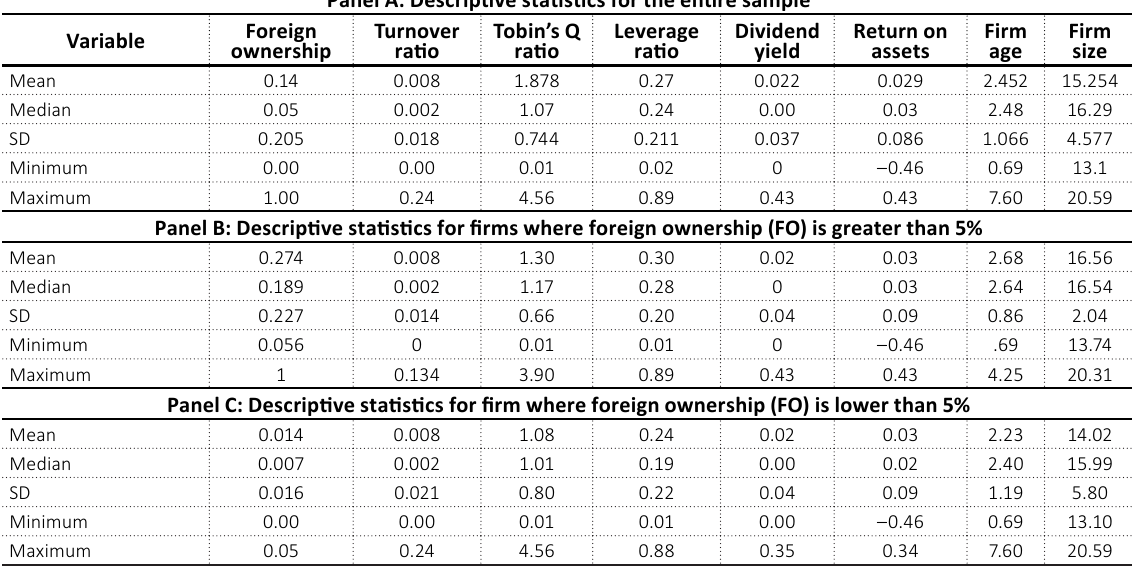
Table 1. Descriptive statistics Panel A: Descriptive statistics for the entire